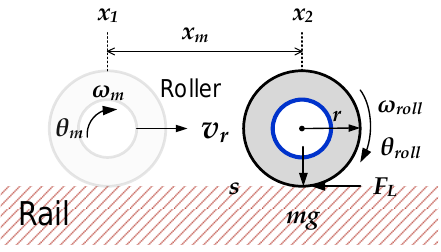
Figure 4. Mathematical model of the proposed system.